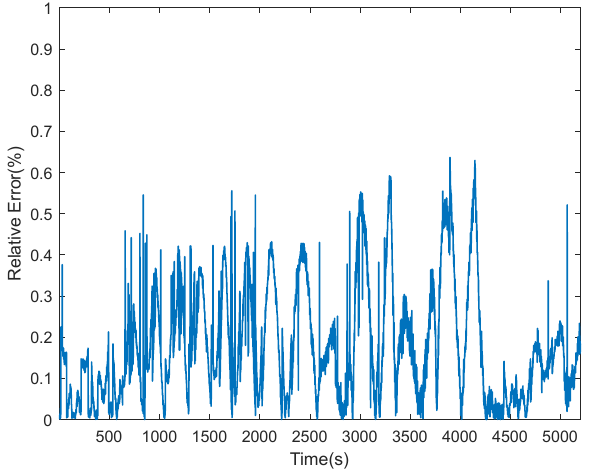
Figure 9. SOC estimation during low-current discharging.